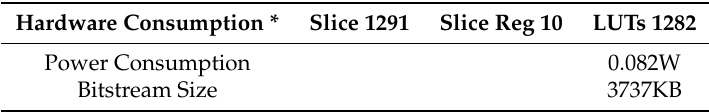
Table 1. Implementation Overhead [2].